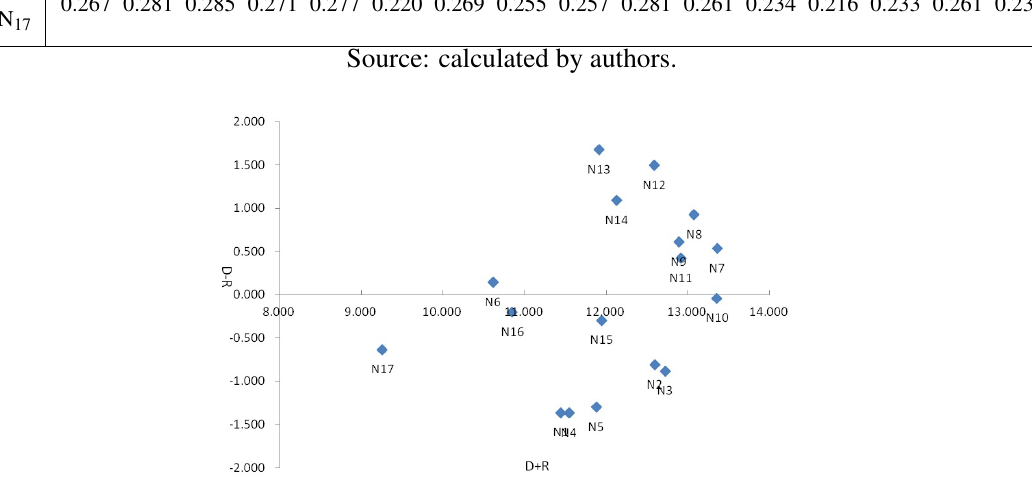
Fig. 3 Cause-effect group